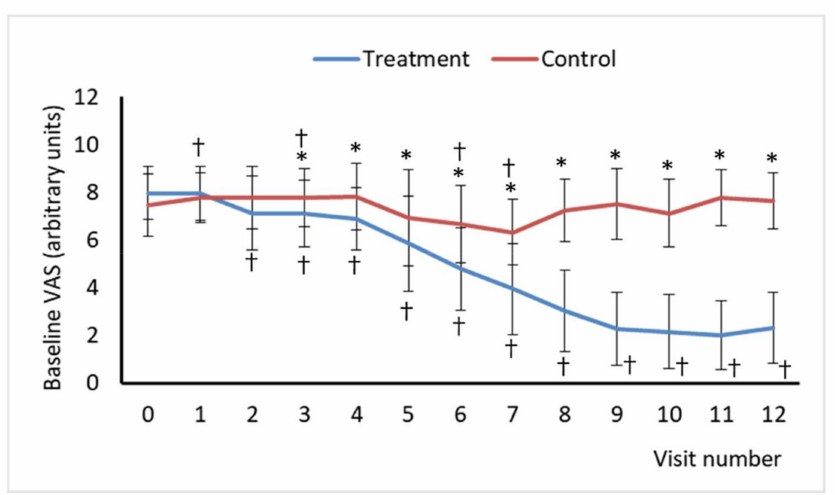
Figure 2. Baseline Visual Analogue Scale (VAS) of Pain scores for visits 0 to12. Baseline VAS was calculated as the average daily pain intensity measures collected during the last 5 days prior to the visit. Asterisk (*) indicates a statistically significant difference between the treatment and control groups at the same visit. Cross (†) indicates a statistically significant difference compared to the baseline (visit 0) for an experimental group.